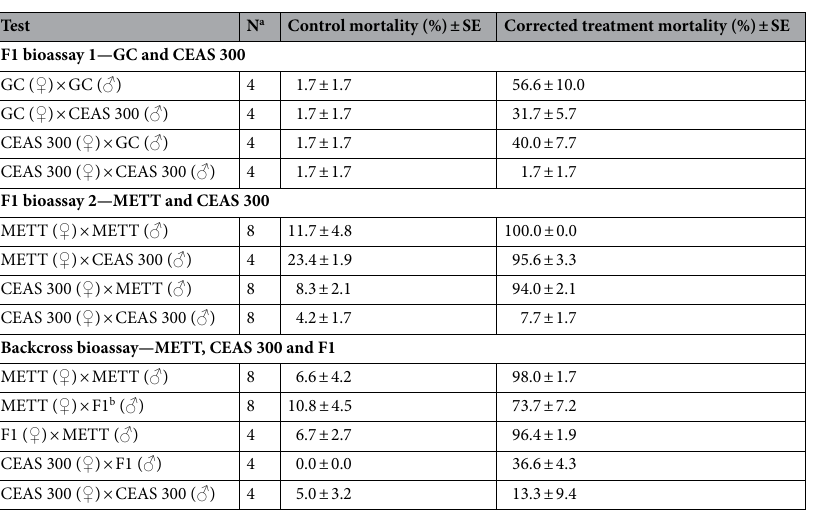
Table 3. Percentage mortality (± standard error, SE) observed in progenies from different crosses when exposed to 800 µg/ml of V-ATPase subunit A dsRNA in 20-day leaf-feeding bioassays. These mortalities were used to determine the genetics of resistance in CEAS 300. a Number of biological replicates performed, each consisting of 15 randomly selected larvae. b F1 generation resulting from crossing METT and CEAS